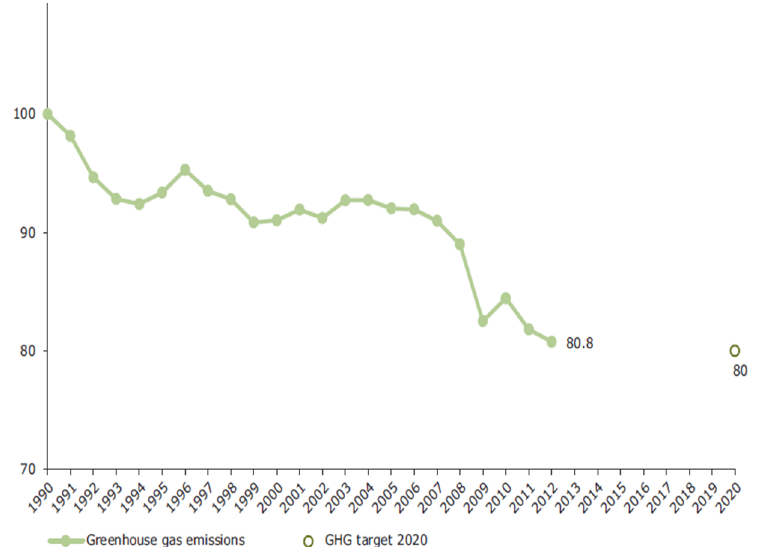
Figure 8. EU-28 greenhouse gas emissions, 1990–2012 (EEA 2014).